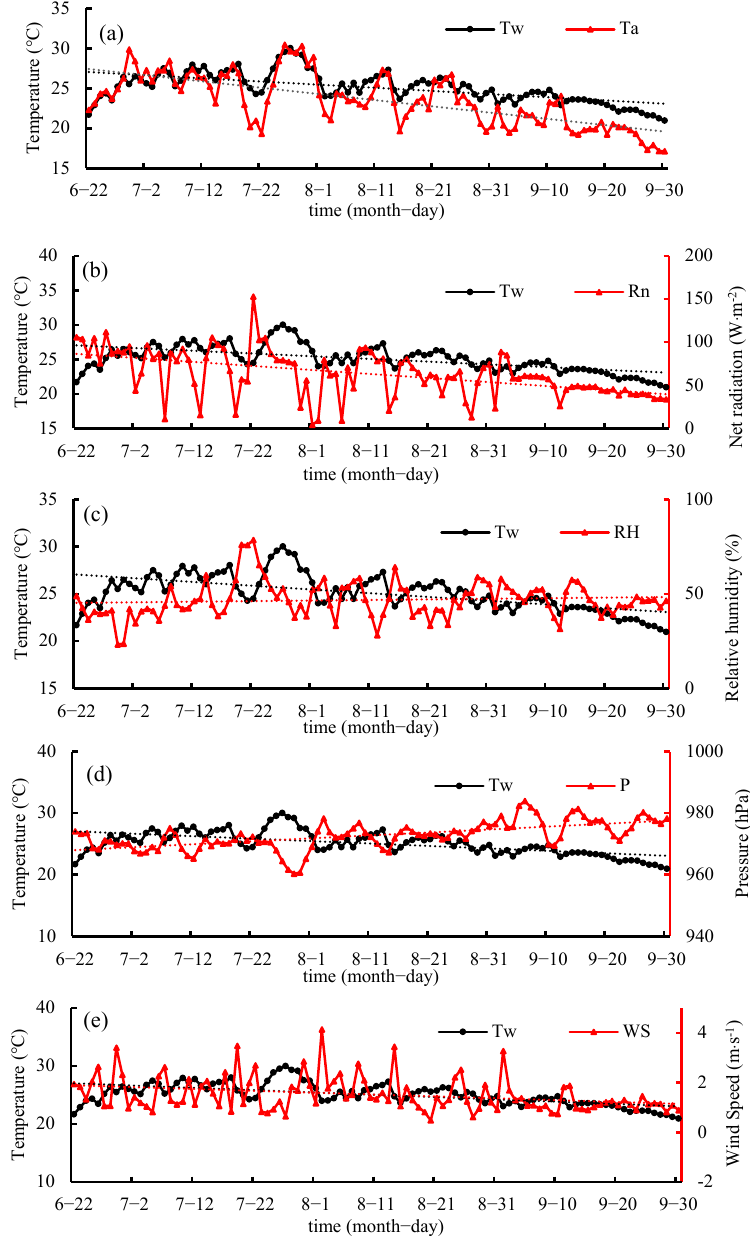
Figure 4. Variation of water surface temperature and meteorological factors with time ( a – e ) show the comparison between air temperature, net radiation, relative humidity, air pressure, wind speed and water surface temperature